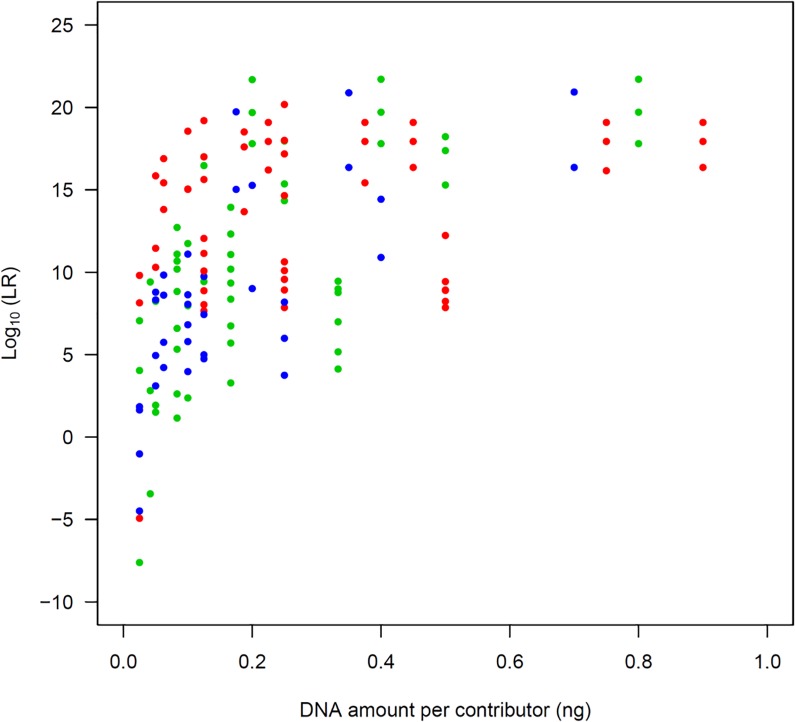
Plots of POI’s DNA amount vs LR values in true-contributor testing.The red, green, and blue plots represent LR values of two-person, three-person, and four-person mixtures, respectively.